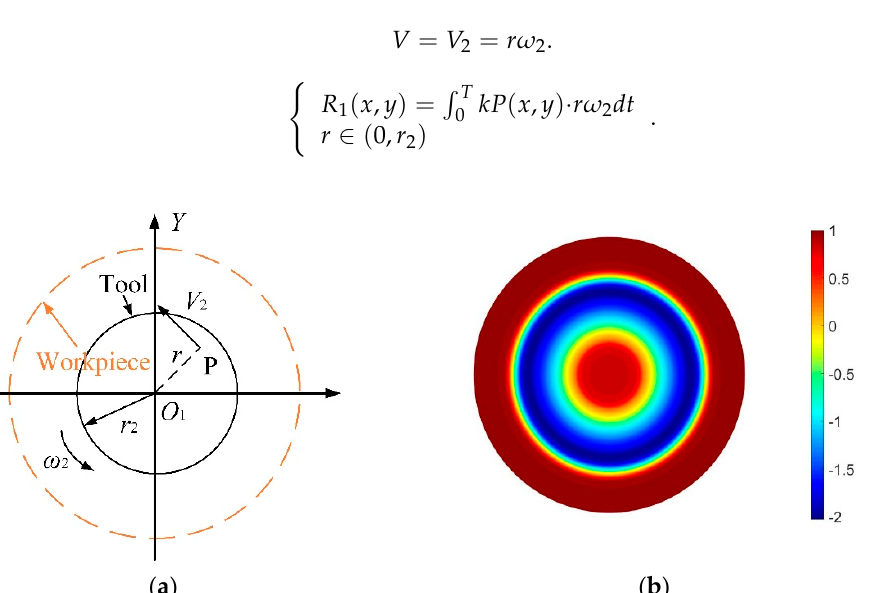
Figure 2. Theory of spin-polishing, ( a ) motion analysis of spin-polishing, ( b ) simulation of TIF.